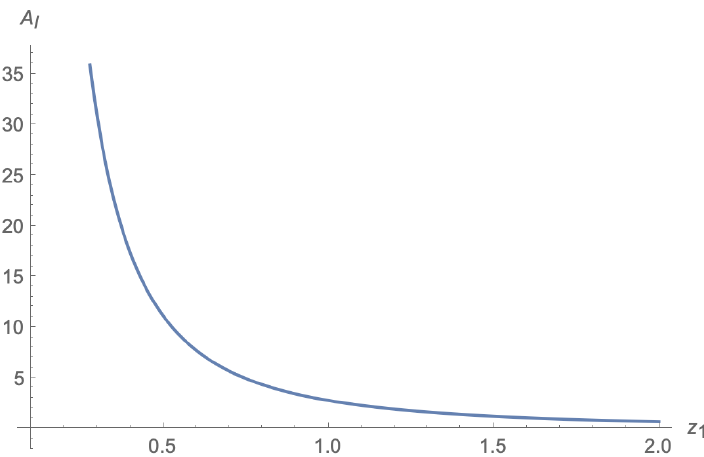
Figure 12 . The figure of A I ( z 1 ) for an AdS space on the branes, where A I denotes the area of extremal surface, and z 1 is its endpoint on the left brane. We take the same parameters ( ρ 1 = 0 . 5 , λ 1 = 0 , ρ 2 = 1 . 2 , λ 2 ≈ − 0 . 246 , V = 1 , d = 4) as in section 3.1. It shows that the area of the extremal surface decreases with z 1 and approaches zero at the AdS horizon z 1 → ∞ . Since the RT surface is defined as the extremal surface with minimal area, we get A I = 0 for the RT surface when the AdS black hole is replaced by an AdS space on